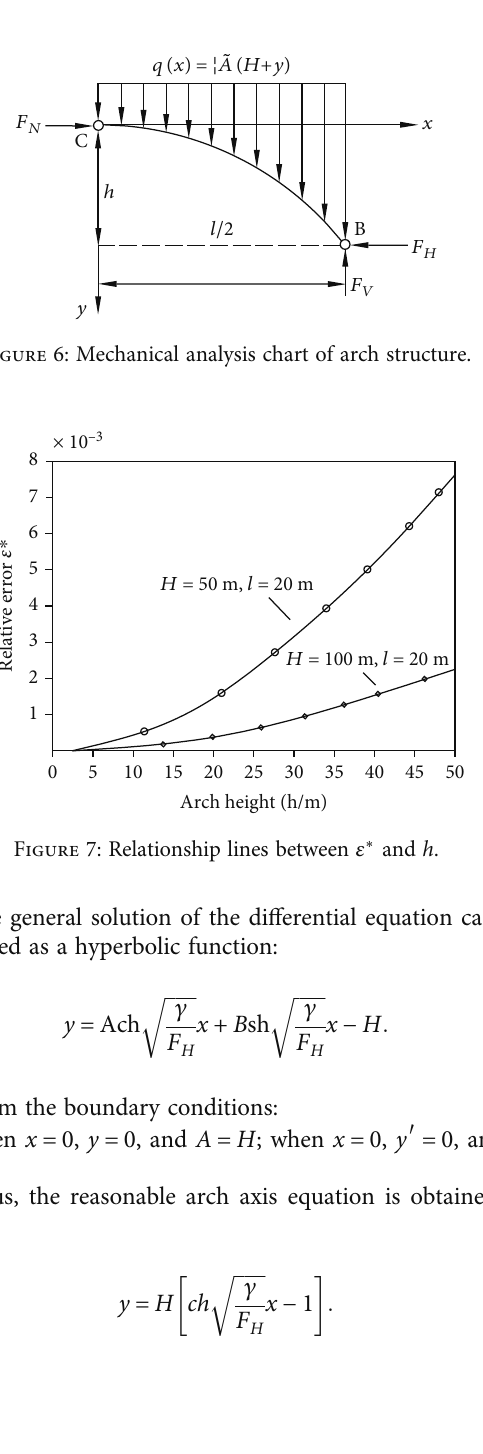
Figure 5: Mechanical model of TSLLA structure.